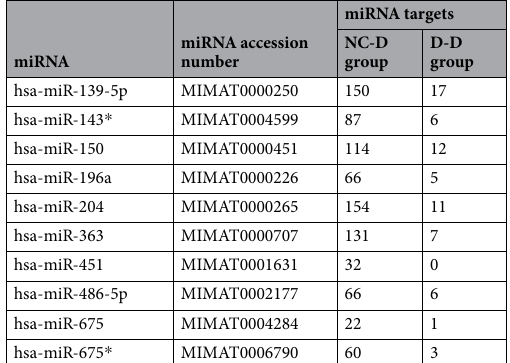
Table 1. The 10 most significantly up-regulated miRNAs in the OM sample and the number of their predicted gene targets in the NC-D and D-D groups.